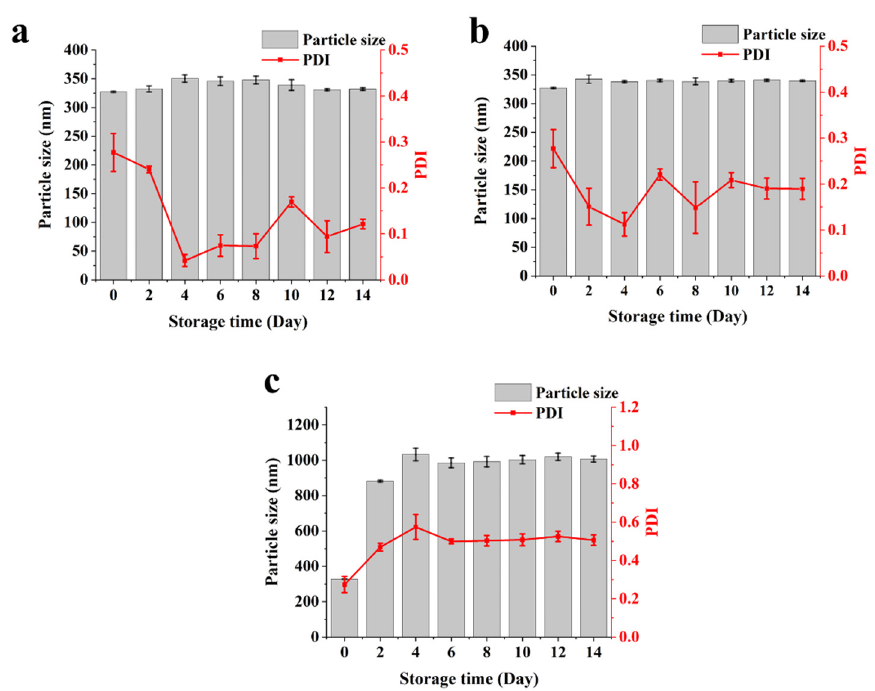
Figure 5. Transmission electron microscopy images of nano-microcapsules produced using emulsifying powers of ( a ) 30%, ( b ) 40%, and ( c ) 50%. The scale bar indicates 5 µm.